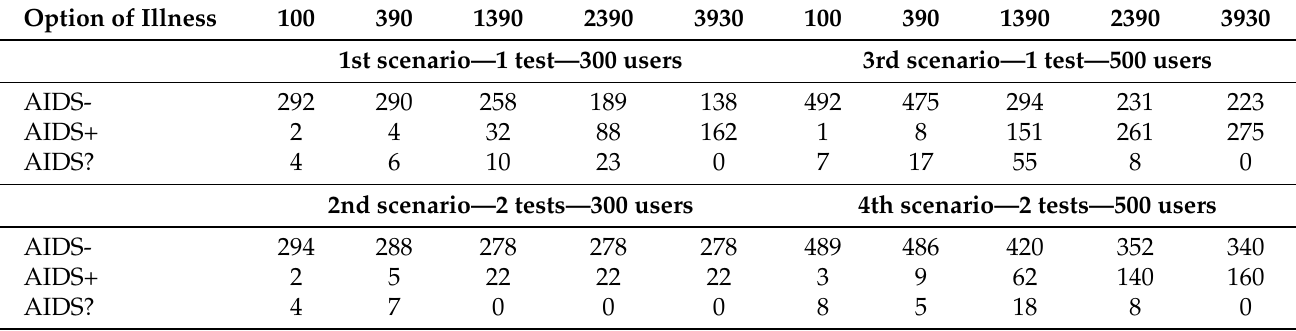
Table 10. Comparison between the four scenarios for a different number of weeks by considering the 9th example with 30% fuzzy.